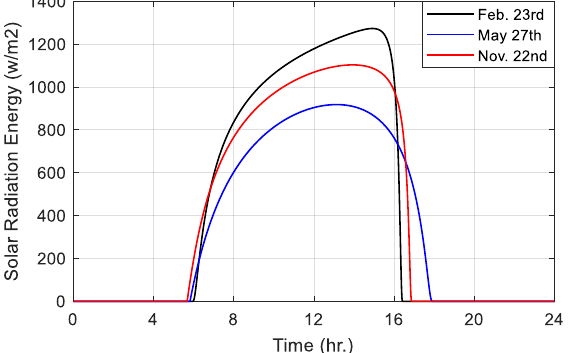
Figure 15. Estimated sun energy on a tilted surface (10-degree tilt angle).